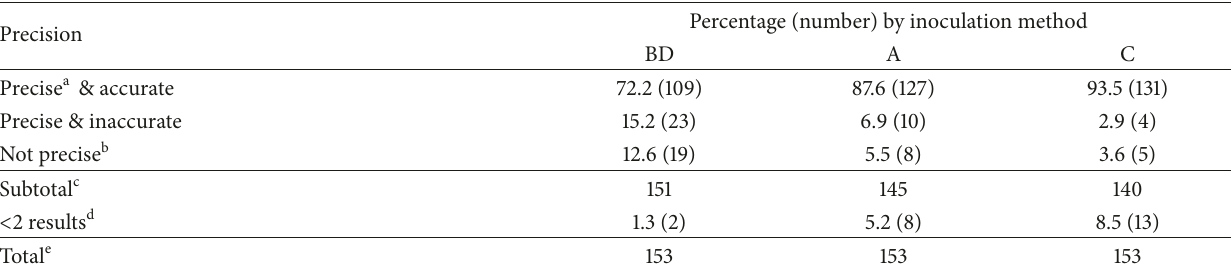
Table 6: Precision of MGIT PZA susceptibility test results stratified by inoculation method. Reproducibility of categorical results for each duplicate pair of